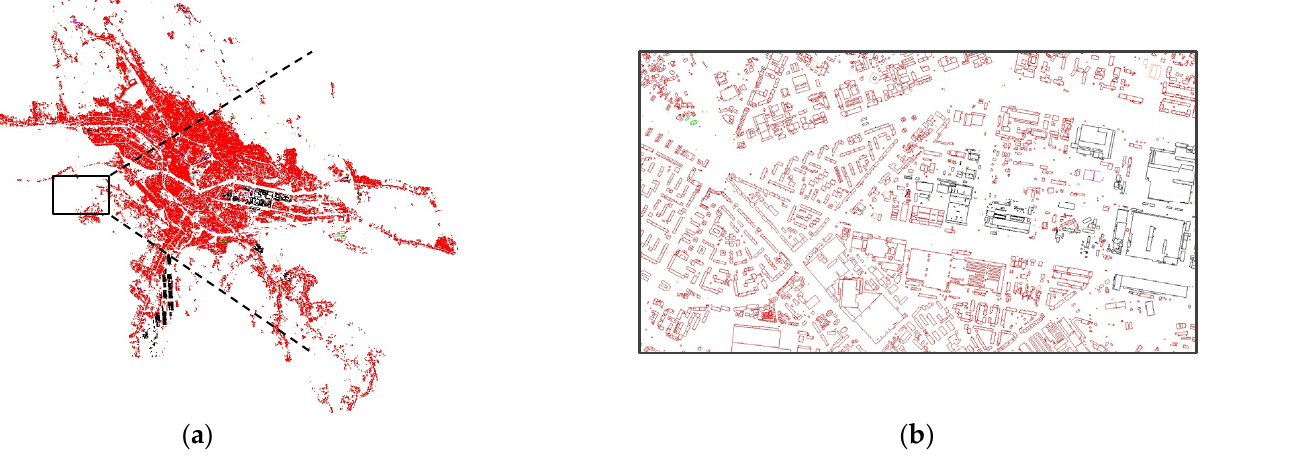
Figure 16. ( a ) Building sub-footprints obtained by stereo-restitution based on ADS-40 aerial images; ( b ) detail.